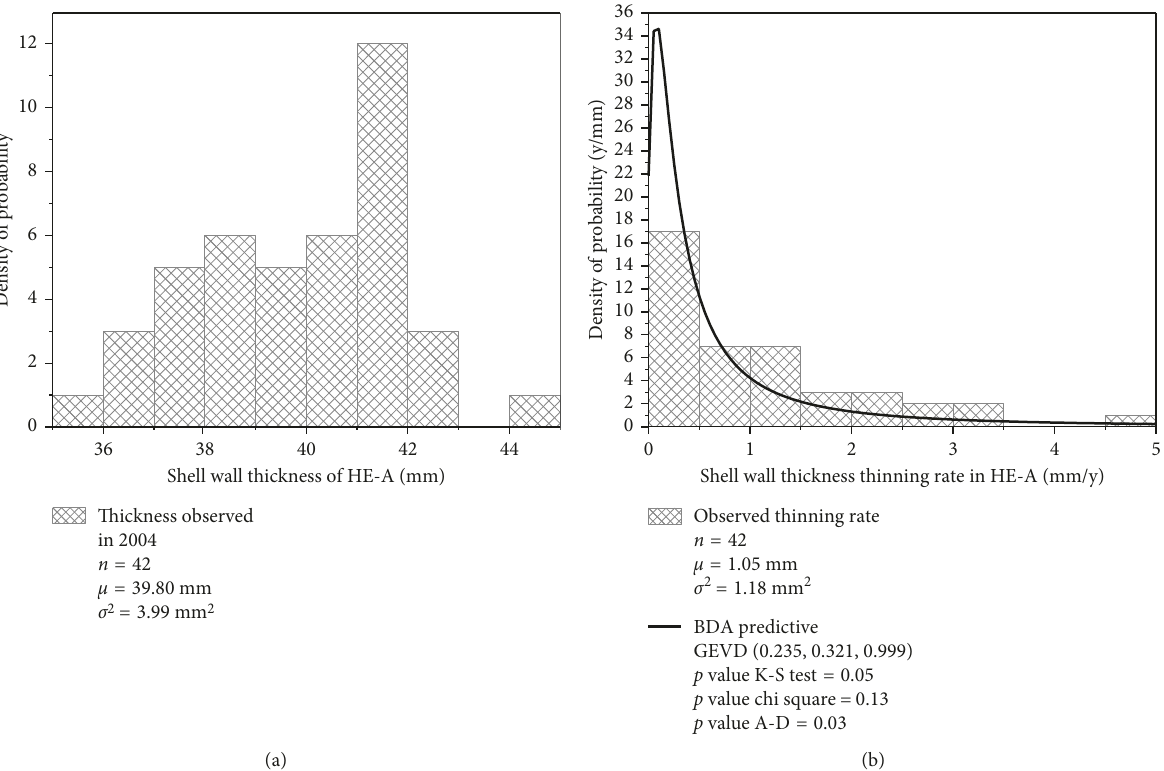
Figure 4: Wall thickness in HE-A in 2004 (a) and wall thickness thinning rate in HE-A in 2004 (b) (all the Probability Density Function (PDF) values plotted in this paper were adjusted in order for the distribution to “look like” the histogram. To do this, it is necessary to convert the PDF to the histogram’s size using the bins’ width and the number of bins. Reference [44] explains this process in